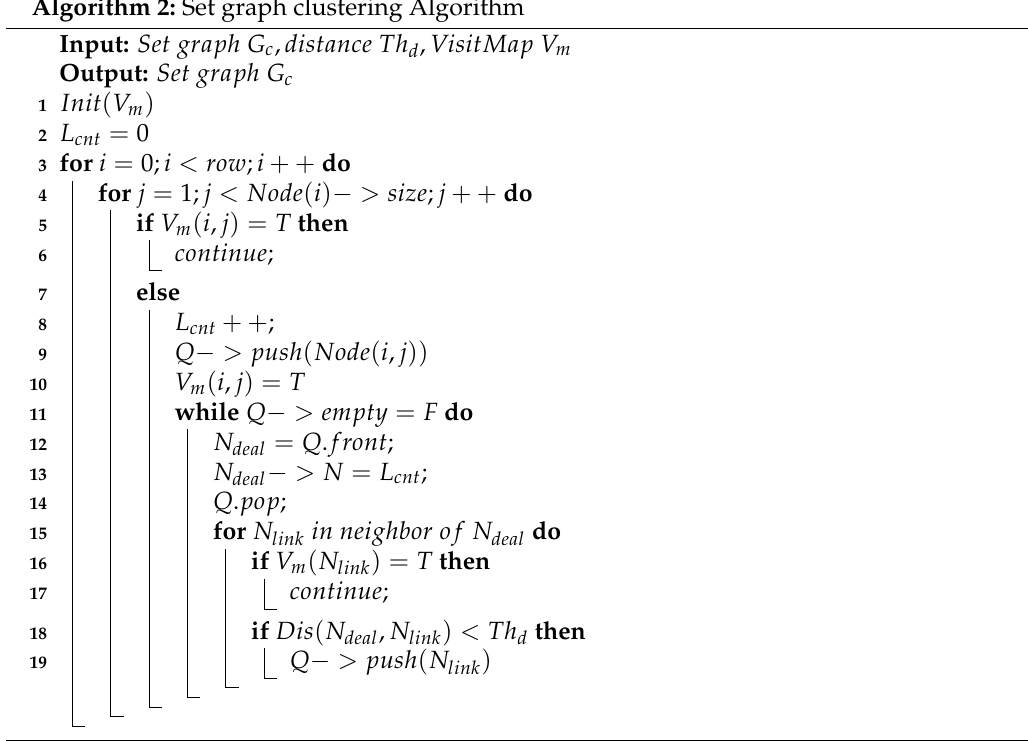
Algorithm 2: Set graph clustering Algorithm